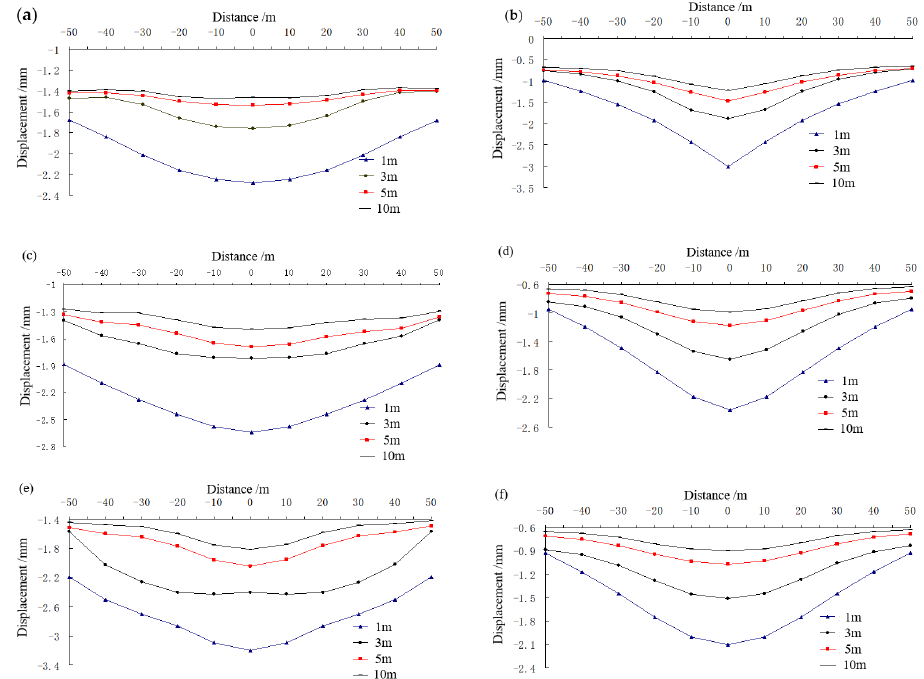
Figure 9. Vertical displacement of measuring points under different rock thickness: ( a ) arch of upper